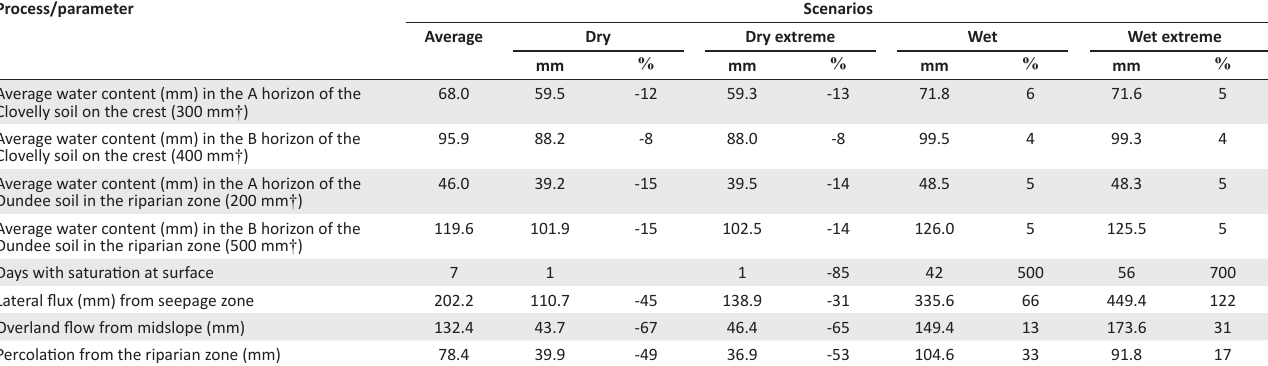
FIGURE 3: Cumulative surface energy balance algorithm for land-derived actual evapotranspiration and cumulative-simulated actual evapotranspiration for: (a) the crest, (b) the footslope and (c) the valley bottom of the studied hillslope together with (d) corresponding correlation coefficients and root mean square error of daily actual evapotranspiration (mm day –1 TABLE 6: Summary of impacts of different precipitation scenarios on key hydrological properties and processes. Values are followed by percentage differences from ‘average’ scenario. Process/parameter